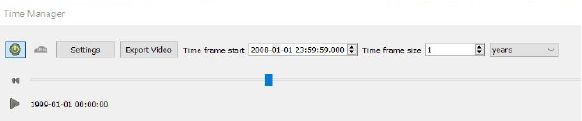
Figure 4. Time slider bar of the Time Manager module